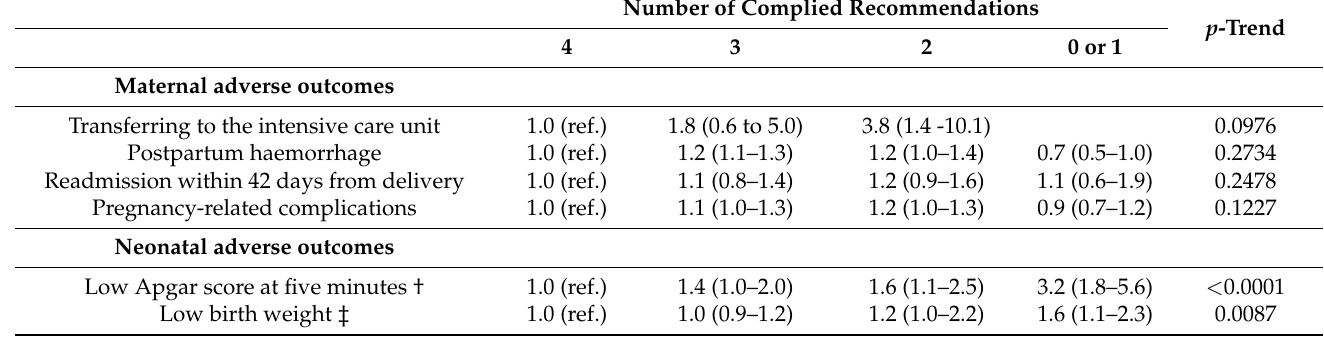
Table 3. Trends in prevalence ratios (and 95% confidence intervals) measuring the association between decreasing number of complied recommendations and maternal and neonatal adverse outcomes experienced from the 122,563 mother–newborn pairs included into the study cohort. Italy, region of Lombardy,